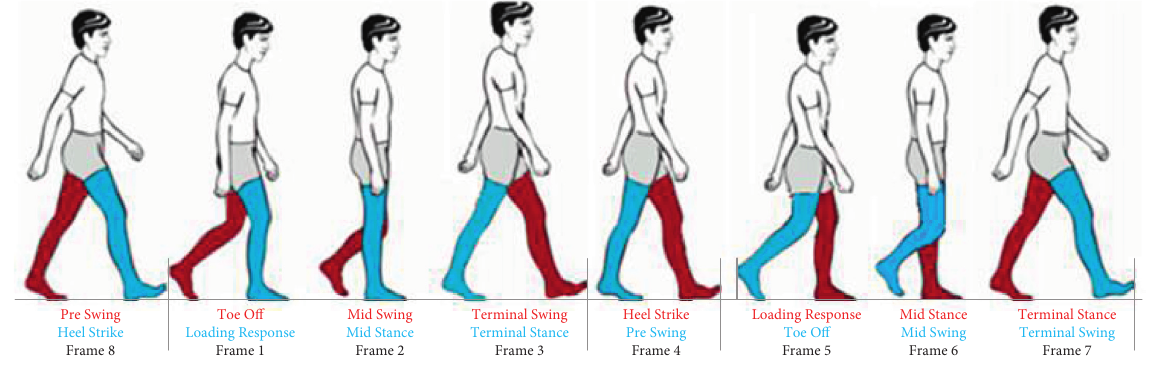
Figure 3: The norm output of the gait cycle frame at human walking gait